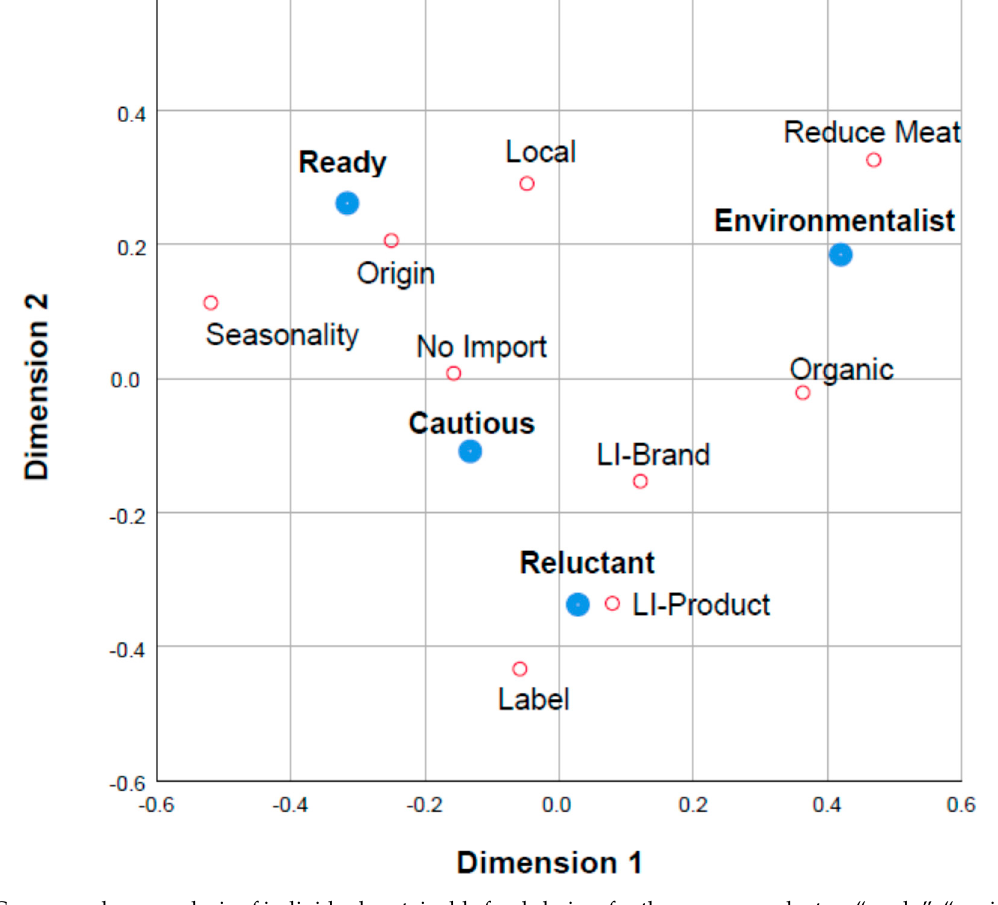
Figure 2. Correspondence analysis of individual sustainable food choices for the consumer clusters “ready”, “environmentalist”, “cautious”, “reluctant”. Indicators: “I choose low-impact food products” = LI-product; “I choose according to the origin of the food product” = Origin; “I choose brands with low environmental impact production” = LI-Brand; “I always prefer to buy organic food” = Organic; “I read the product label carefully” = Label; “I prefer to buy local products” = Local; “I buy seasonal products” = Seasonality; “I avoid foreign brands” = No import, “I’ve reduced my meat consumption” = Reduce Meat. N.B. The quotes for “I haven’t changed my eating habits” were not considered since they accounted for less than 5% of the respondents.